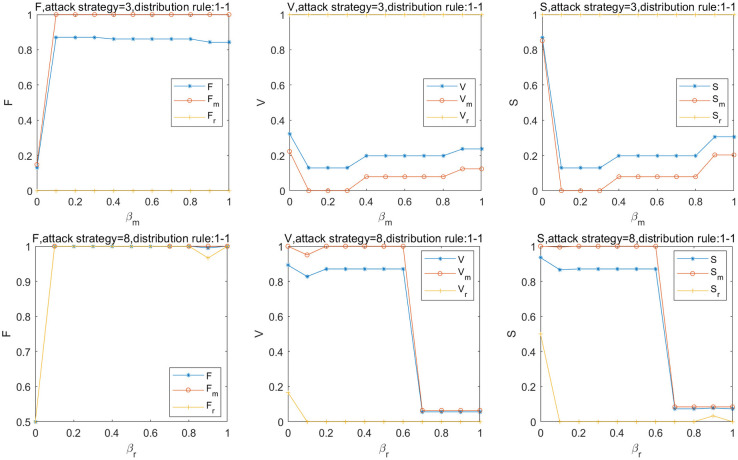
Effect of βm & βr on robustness of the SRN.